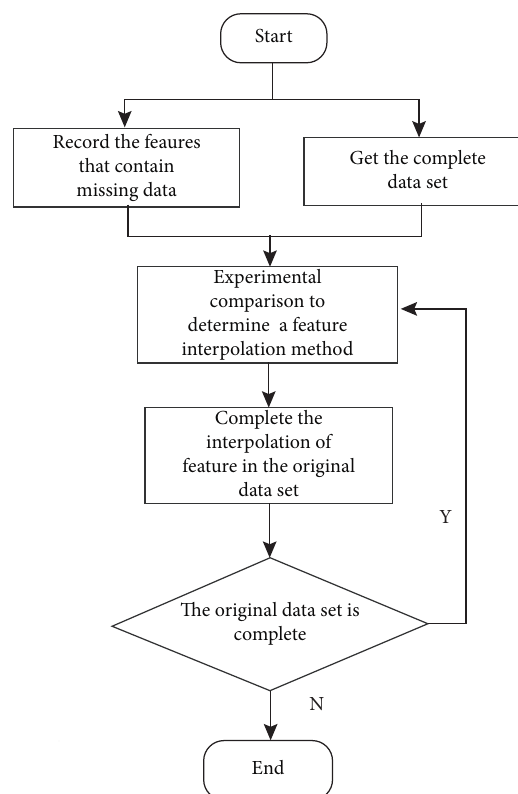
Figure 2: Flow chart of missing data